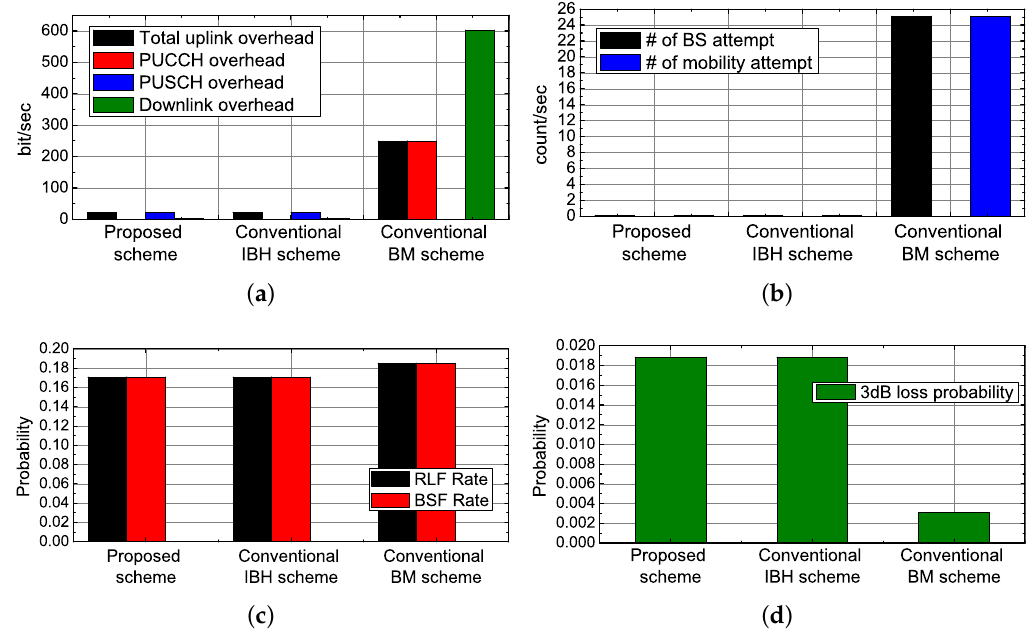
Figure 4. Simulation results in single-gNB environment. ( a ) overhead performance, ( b ) mobility attempts, ( c ) mobility failure rates, ( d ) 3 dB-loss probability.